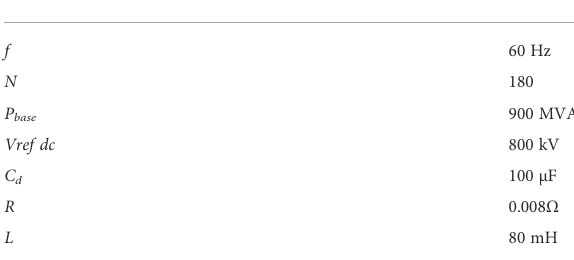
TABLE 1 The Parameters of grid and